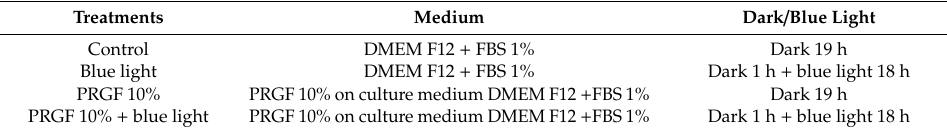
Table 1. Experimental groups for ARPE19 analysis.